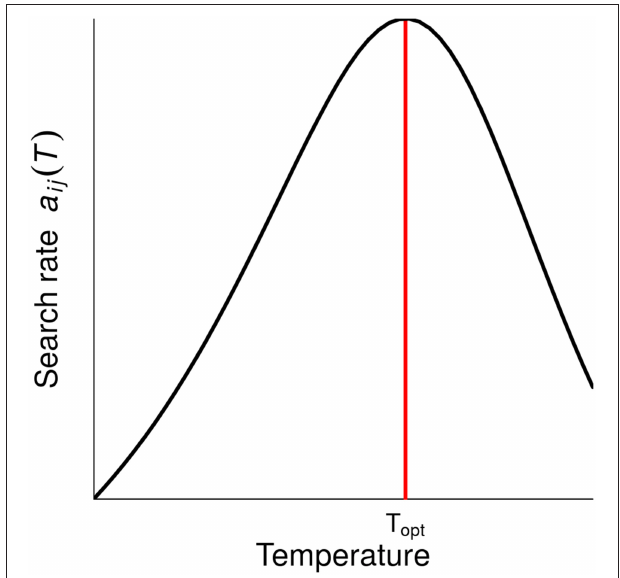
FIGURE 2 | Effect of temperature on the search rate a ij which is equal to per capita interaction strength, IS pc , as described by Equation 2. T opt is the temperature at which the rate value is maximal. Below T opt , the individual stands within its PTR (“Physiological Temperature Range”), where the trait performance increases with temperature, whilst above T opt the trait performance decreases. Note that growth rate µ also follows this equation, but mortality rates z i monotonically increase with